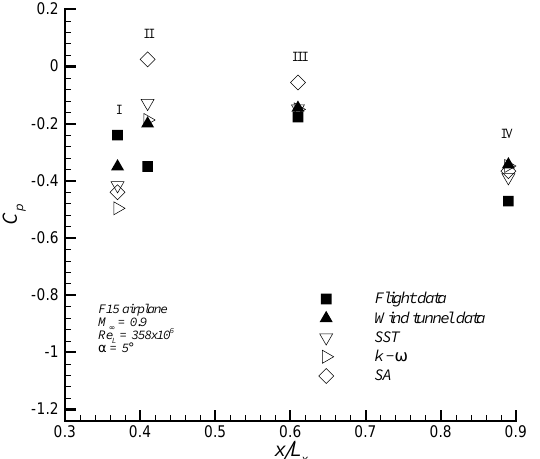
Figure 15. Variation of the pressure coefficient in the top surface along x / L x of F15 aircraft for present numerical data (open symbols) experimental data (closed symbols).